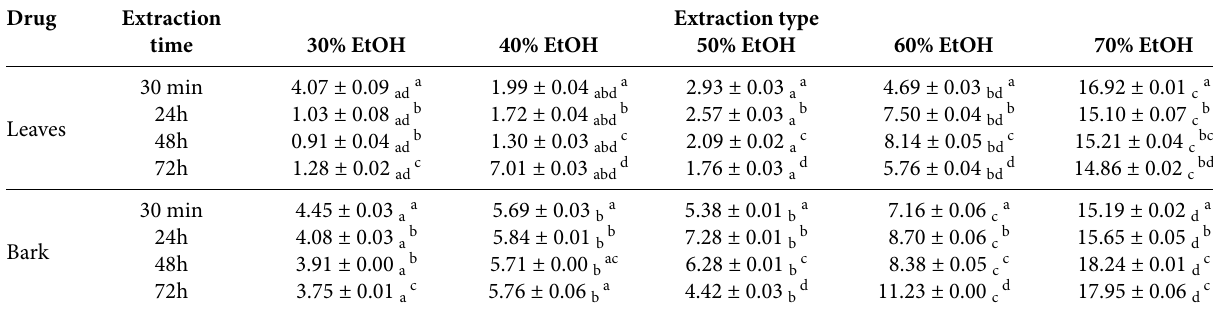
Table 4. Total flavonoids content of S. caprea leaves and bark extracts [mg of quercetin equivalents per g of dried extract]